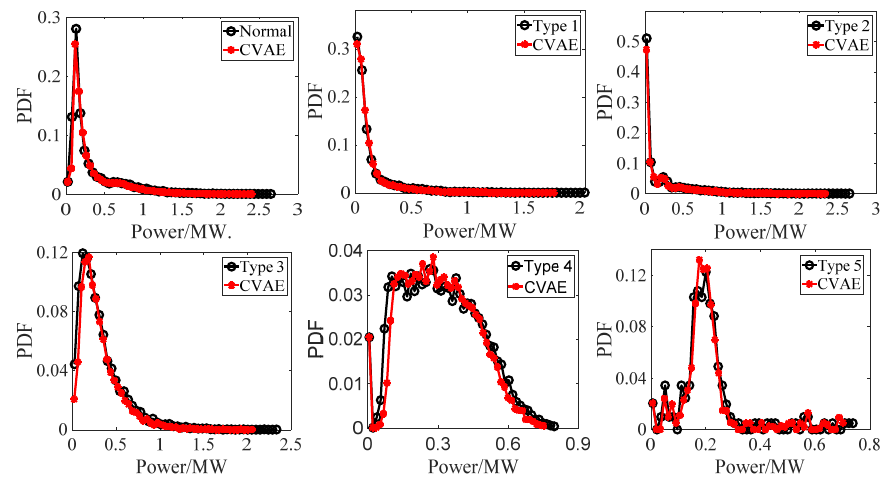
Figure 7. Comparison of probability distribution between real samples and generated samples.